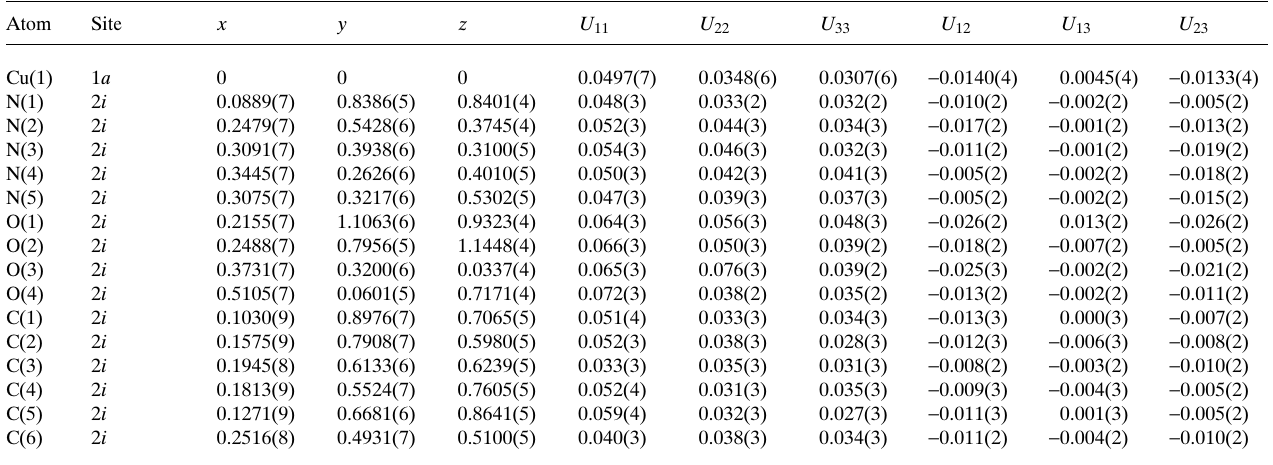
Table 3. Atomic coordinates and displacement parameters (in Å 2 ) .